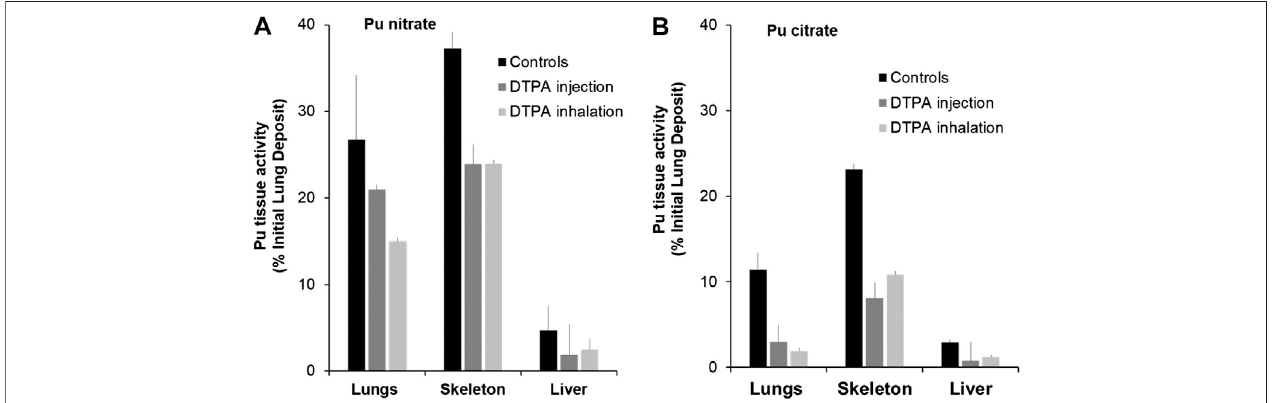
FIGURE 1 | Effect of single systemic or local DTPA administration on tissue activity levels following lung contamination with Pu nitrate (A) or Pu citrate (B) . Animals were contaminated by intra-tracheal instillation of either Pu nitrate ( A : 5.5 kBq) or Pu citrate ( B : 2.8 kBq) and were euthanized at eight or seven days respectively after contamination. After Pu nitrate contamination (A) , treatments at 2 h were either intravenous injection of DTPA solution (30 µmol/kg) or insuf fl ation of DTPA powder (approximatively 5 µmol/kg). After Pu citrate contamination (B) , treatments at 1 h were either intravenous injection of DTPA solution (15 µmol/kg) or inhalation of nebulized DTPA (1.1 µmol/kg). Data are expressed as a percentage of the initial lung deposit and are the means of three – six